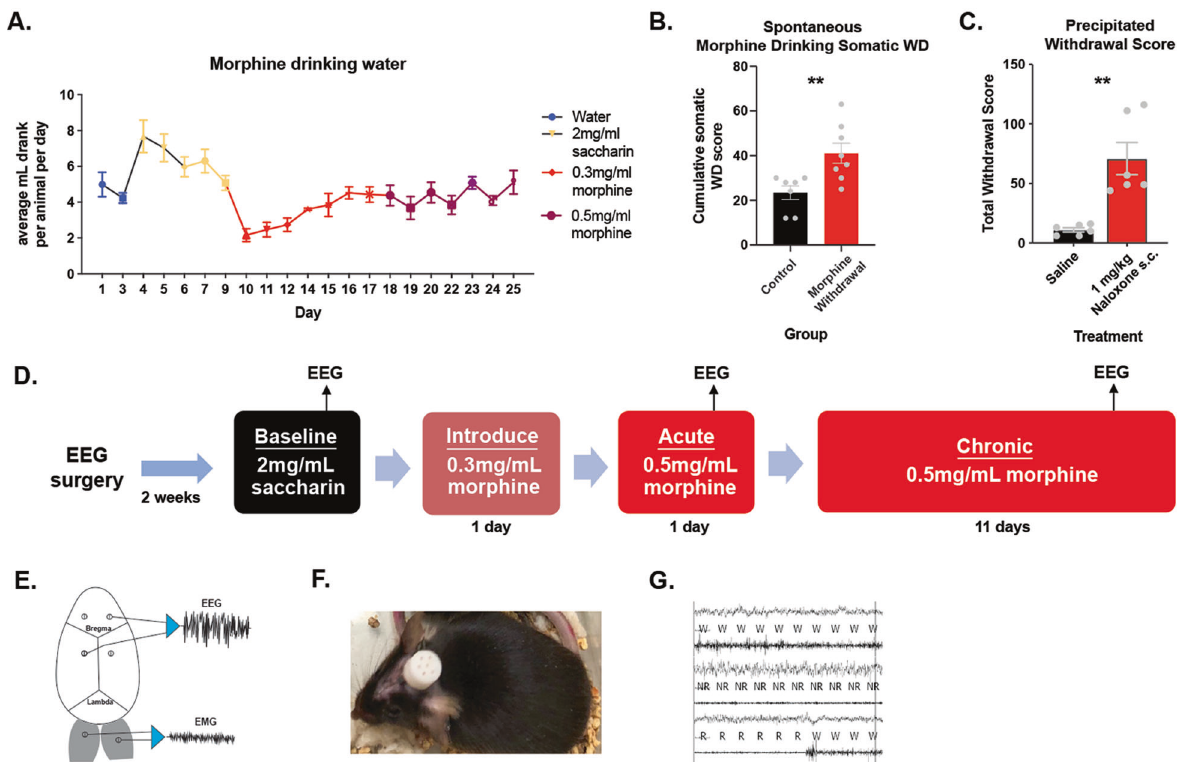
Fig. 1 Experimental Design. A Amount consumed in drinking water in average mL per animal per day. B Spontaneous somatic withdrawal signs between morphine-treated mice and saccharin-treated mice. C Somatic withdrawal signs in mice that drank morphine precipitated by 1 mg/kg Naloxone or Saline. D Timeline of experiments. E Example schematic showing placement of electrodes 1 mm from bregma in each quadrant and on the nuchal muscles with example EEG and EMG traces. F Image of mouse with electrode cap. G Example traces of Wake, NREM, and REM in 4 s